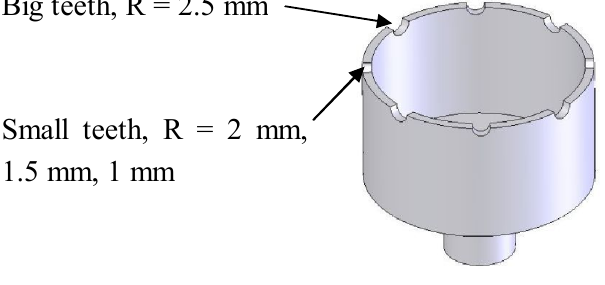
Figure 8. Geometry errors of the resonator.